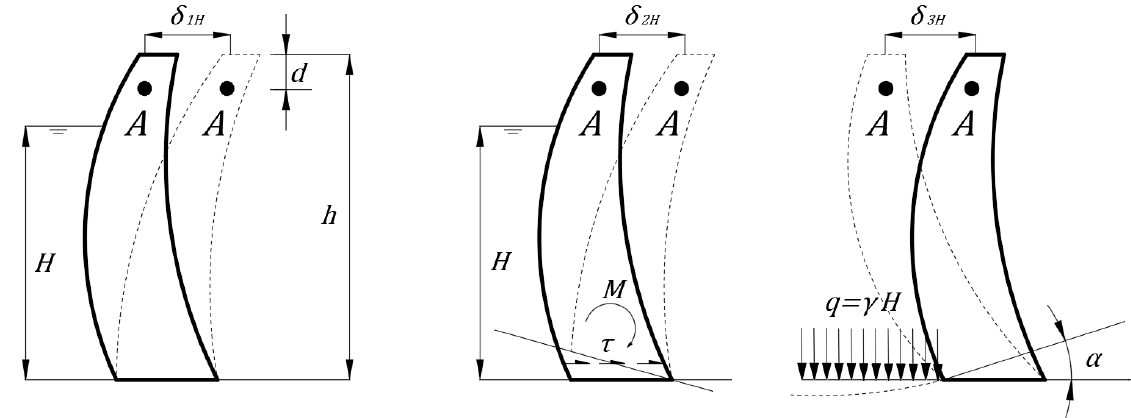
δ , δ , δ for an arch dam . Figure 1. Schematic diagram of water components δ 1 H , δ 2 H , δ 3 H for an arch dam. 1H 2H 3H